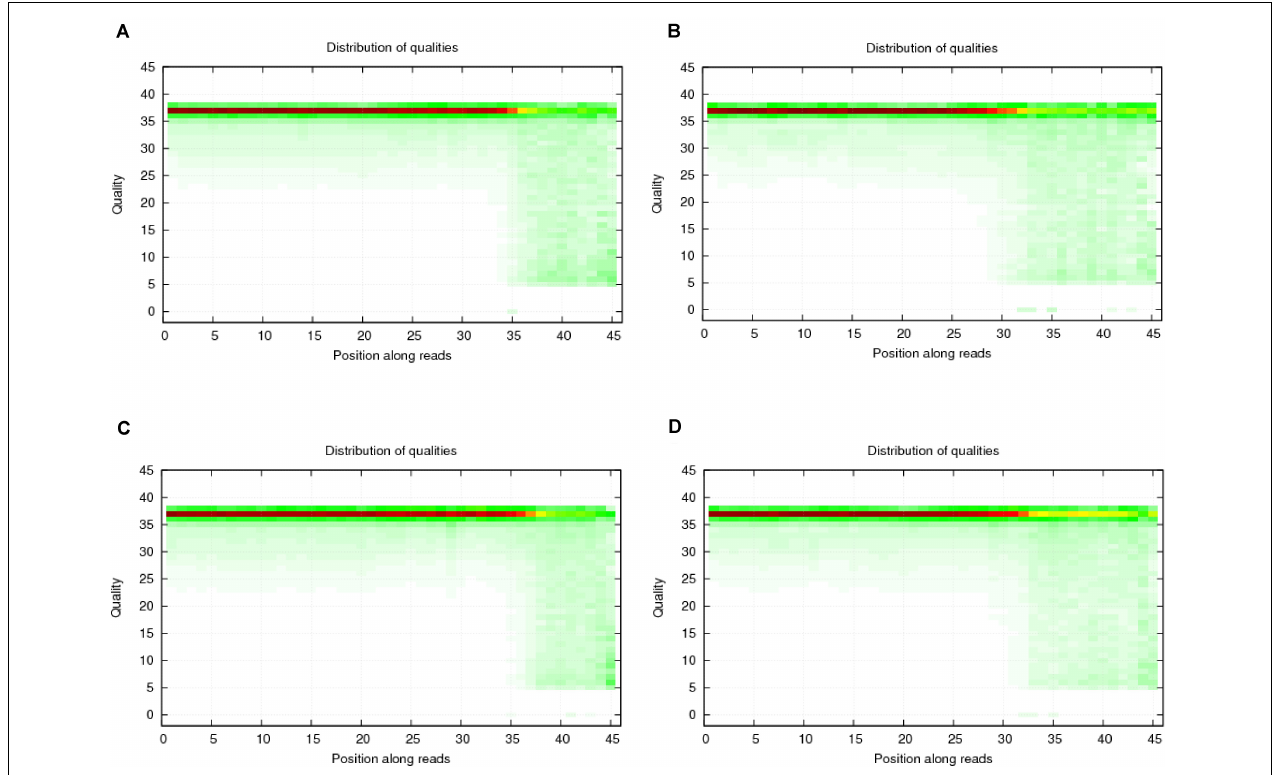
FIGURE 1 | Quality distribution of four sequencing results. (A) Negative control group; (B) Positive control group; (C) P-ONE group; (D) P-TWO group. From such four bar plots, we can confirm that all sequencing results are of high quality (greater than 20), satisfying the requirements for further processing and